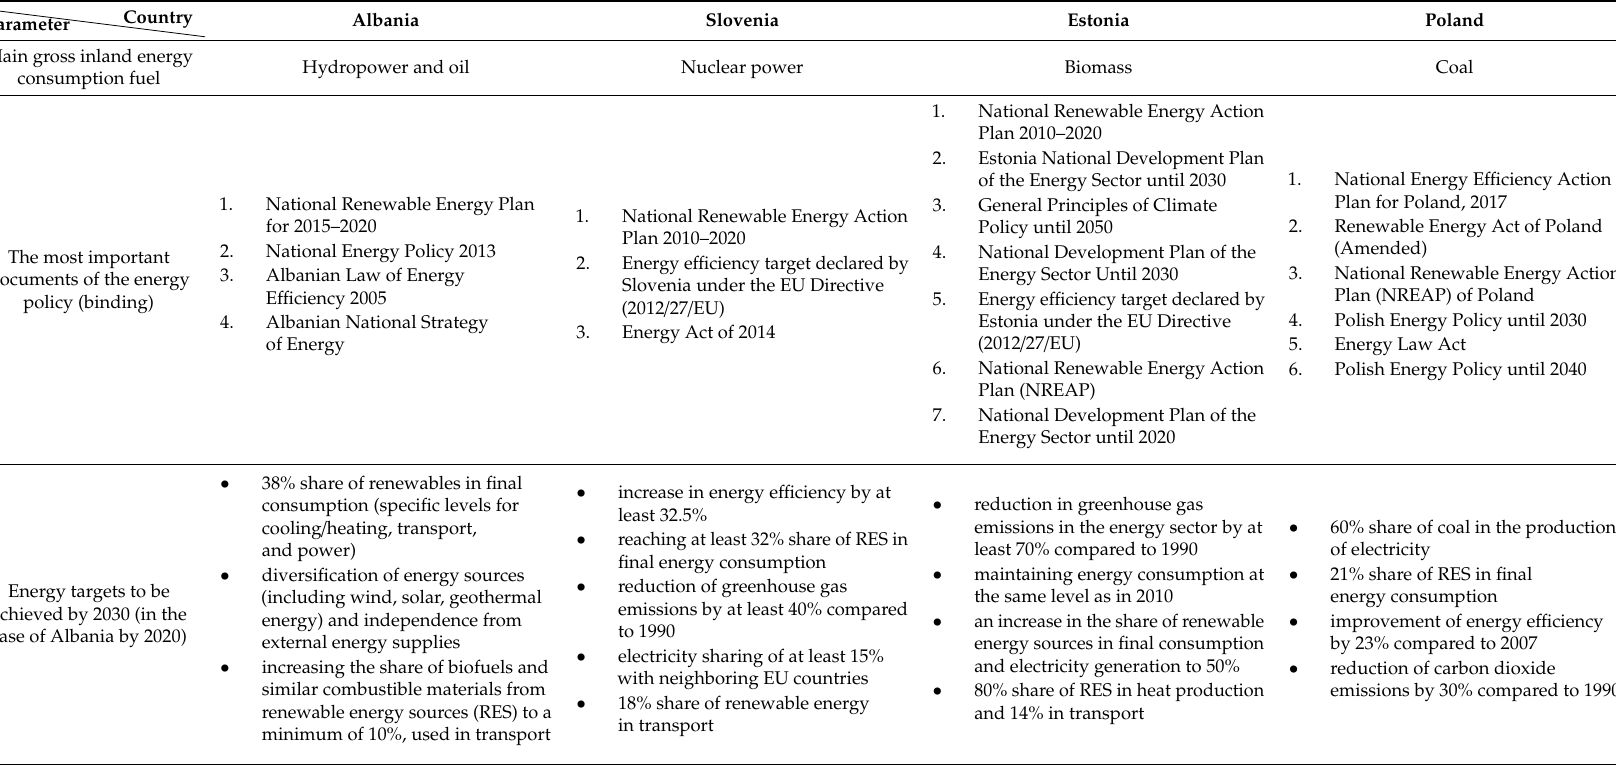
Table A1. The most important information regarding energy policy in Albania, Slovenia, Estonia, and Poland